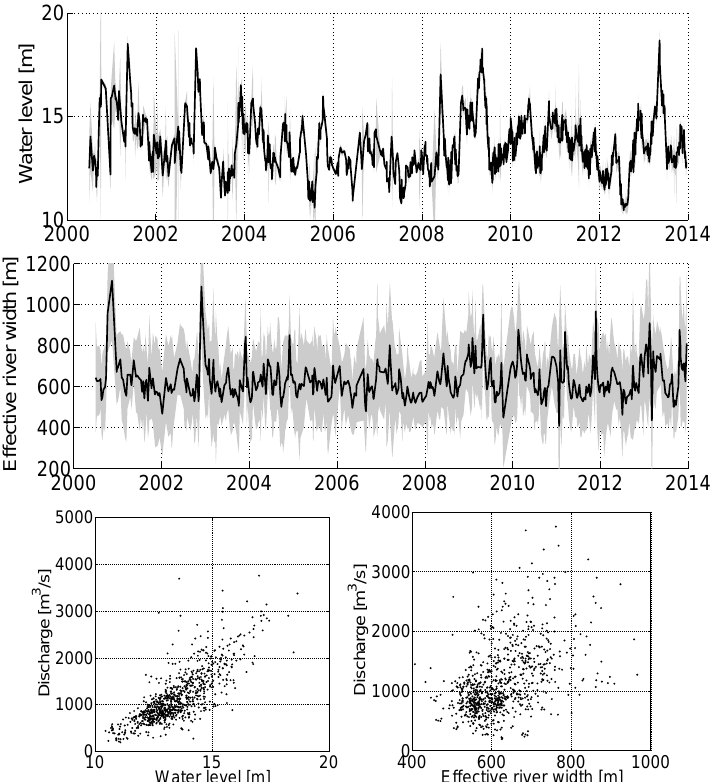
Figure 4. (Top panel) Water level time series from satellite altimetry and effective river width from satellite imagery for Reach 12. (Bottom panel) Scatter plot of river discharge against water level (correlation coefficient = 0.73) and effective river width (correlation coefficient =